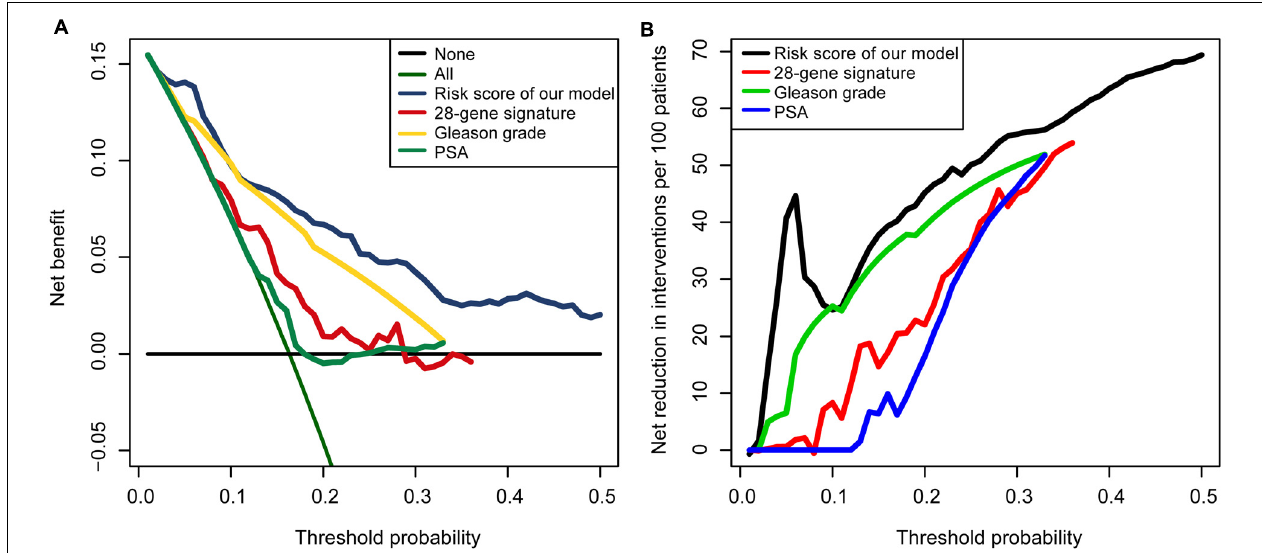
FIGURE 9 | Decision curve analyses suggested that the model had good clinical benefits: (A) The model had higher net benefit and wider threshold probability range. The green line is the net benefit of providing all patients with intervention, and the horizontal black line is the net benefit of providing no patients with intervention. (B) The net reduction analyses demonstrated in how many patients an intervention could be avoided without missing any poor